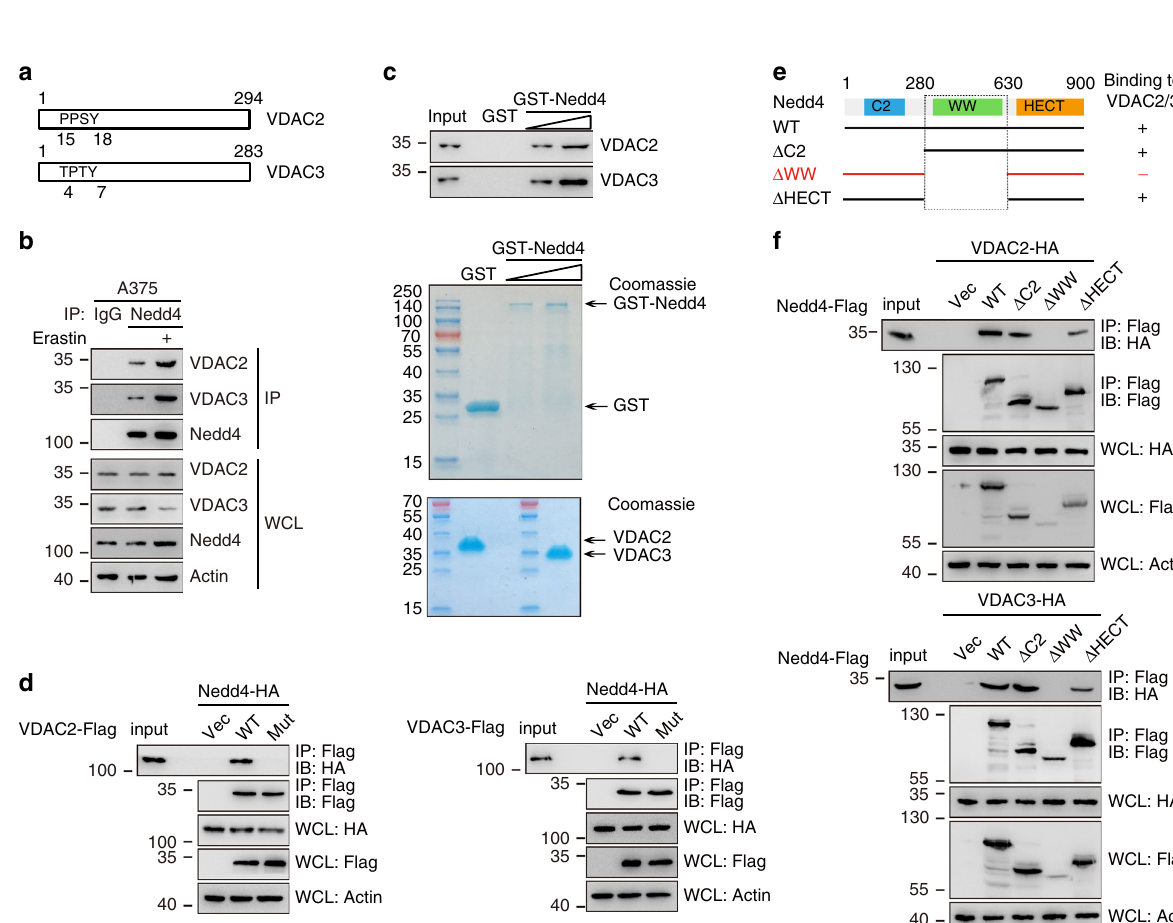
Fig. 1 Erastin treatment promotes ubiquitin – proteasomal degradation of VDAC2/3. a A375 cells expressing GFP-VDAC2 or GFP-VDAC3 and mCherry- VDAC1 were treated with erastin (5 µ M). Representative images were taken at the indicated time after treatment. Scale bars, 10 μ m. Fluorescence intensity was assayed using Image J software. b A375 cells were treated with erastin at the indicated time (0 – 12 h, 10 µ M) or indicated concentrations (0 – 10 µ M, 12 h). Western blot analysis shows the expression of VDAC2, VDAC3, and VDAC1 in indicated cells. c , d Knockdown of VDAC2 and VDAC3 individually or in combination suppressed erastin-induced ferroptotic cell death. Indicated cells were treated with erastin (5 µ M) for 24 h. Cell viability was assayed using a CCK8 kit. The lipid formation was measured by MDA assay. The accumulation of Fe 2 + was measured by iron detection assay. The concentrations of GSH and GSSG were detected by relative assay kits ( c ). The protein level of VDAC2/3 was assessed by immunoblotting ( d ). e , f Overexpression of VDAC2 and VDAC3 together increased erastin-induced ferroptotic cell death. Indicated cells were treated with erastin (5 µ M) for 24 h. Cell viability, intracellular MDA, Fe 2 + , GSH, and GSSG levels were measured ( e ). The overexpression of VDAC2/3 was assessed by immunoblotting ( f ). g A375 cells were treated with erastin (5 µ M) for 8 h, then MG132 (50 mM) or NH 4 Cl (50 mM) were added into the culture medium for 4 h. The protein level of VDAC2/3 was analyzed by western blot. h A375 cells were transfected with indicated DNA constructs. After 48 h transfection, cells were treated with DMSO or erastin (5 µ M) for 8 h, then MG132 (50 mM) was added into the culture medium for 4 h. Lysates from A375 cells were immunoprecipitated with mouse anti-Myc. Western blots were performed to analyze the presence of indicated proteins and levels of ubiquitination. Actin was used as a loading control. Data shown represent mean ± SD from three independent experiments. Comparisons were made using Student ’ s t test. * p < 0.05; ** p < 0.01; *** p < 0.001.